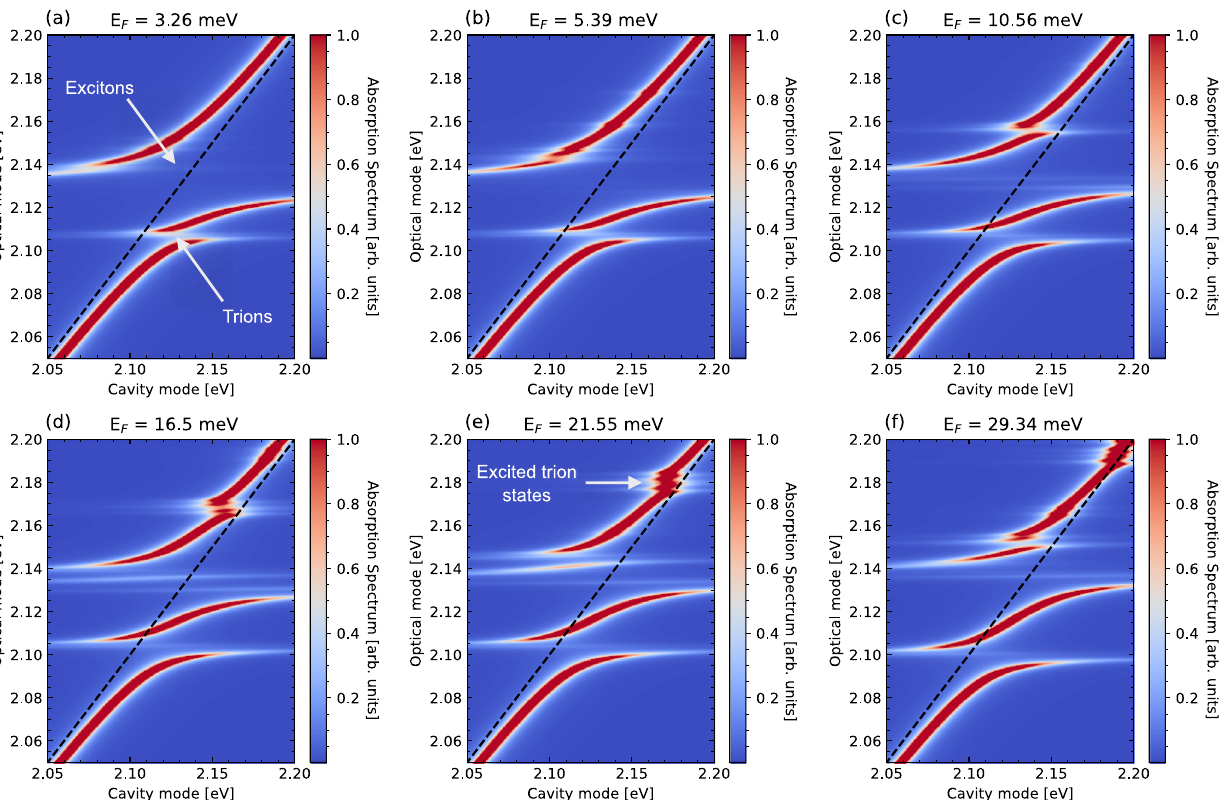
Fig. 5 Polaritonic spectra. Absorption is shown as a function of detuning for increasing Fermi energy (left-to-right). We consider σ + polarization for the cavity mode. Color bars de fi ne the intensity in arbitrary units. In all the spectra, from low (3.26 meV) to high (29.34 meV) Fermi energy, we see the emergence of trion modes at ~2.1 eV with considerable Rabi splitting (~10 meV), being signi fi cantly larger than the broadening γ = 1 meV. The exciton-polariton features the appearance of the additional mode inside the polaritonic gap. The additional splitting at high free electron concentration is attributed to the higher-order trion